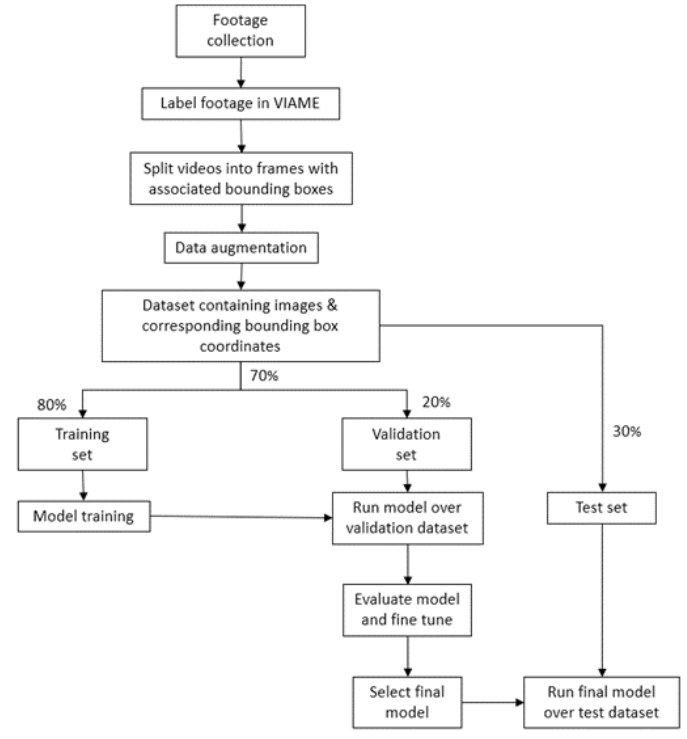
Figure 6. Overview of methods used to create the object detection